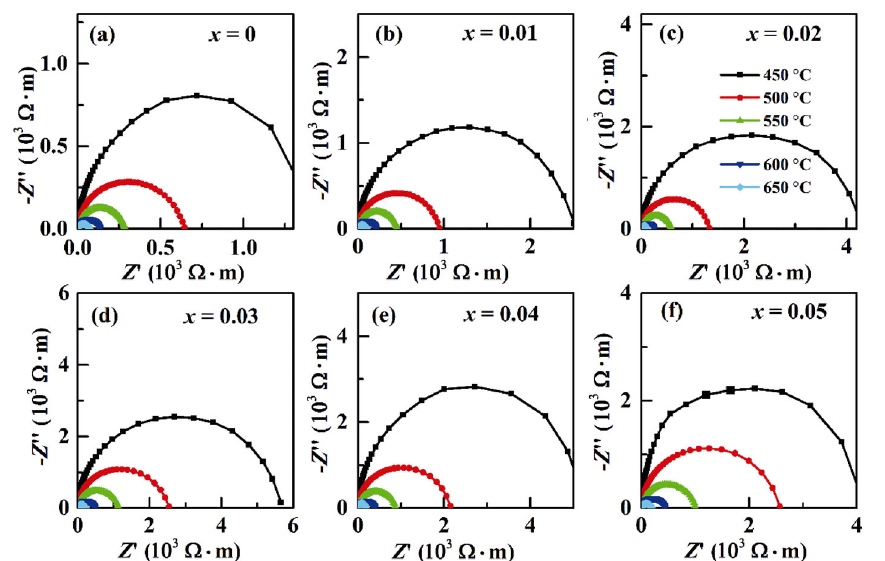
Fig. 6 Impedance spectra at a series of temperatures for (0.99– x )KNNS–CZ– x BNH ceramics: (a) x = 0, (b) x = 0.01, (c) x = 0.02, (d) x = 0.03, (e) x = 0.04, and (f) x = 0.05.